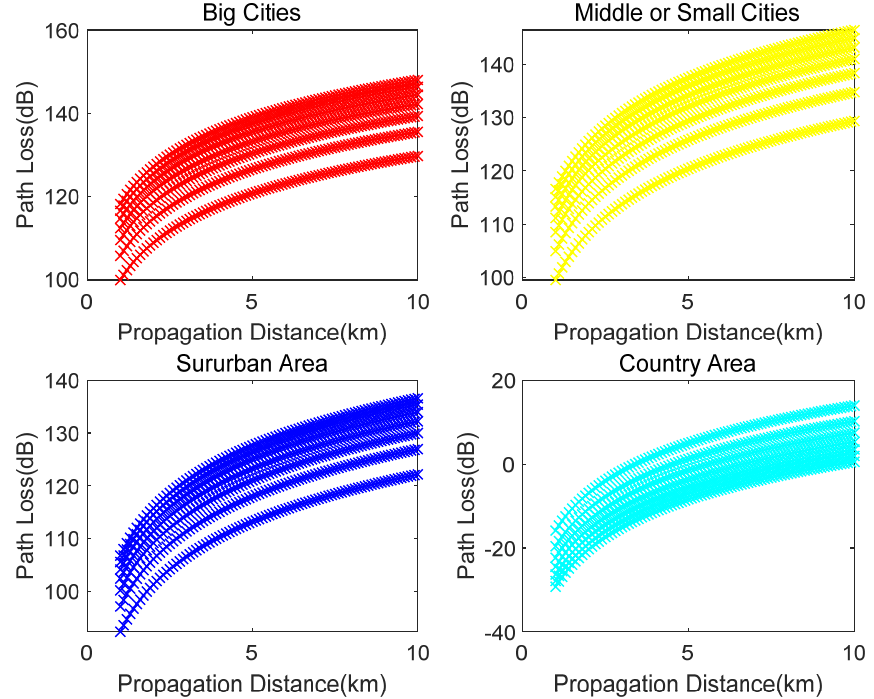
Figure 2. Variation curve.